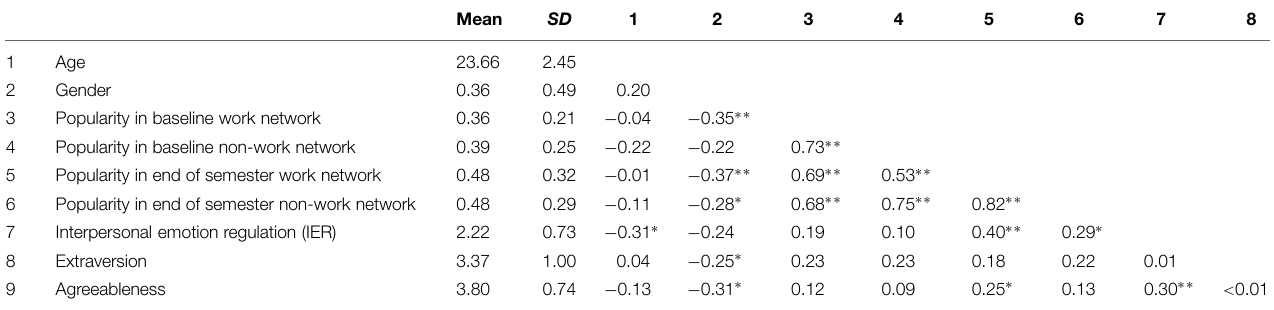
TABLE 1 | Correlations between main study variables in Study 1.